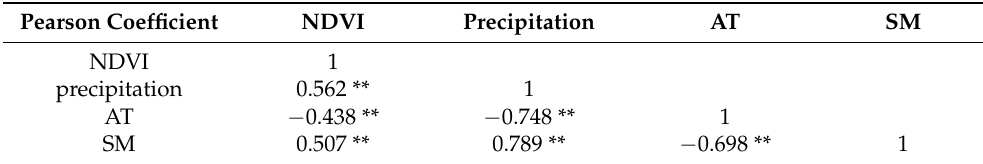
Table 2. Correlation between NDVI and environmental factors. Pearson